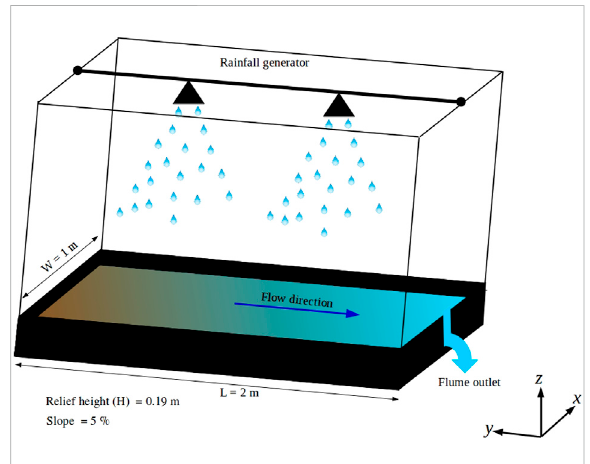
FIGURE 1 Schematic of the fl ume experiment. The sediment elevation was measured from the outlet ( z = 0) and with respect to the horizon. The relief height (the maximum elevation) was 0.19 m. Details on the experimental setup are given in the Supplementary materials of Cheraghi et al. (2018).